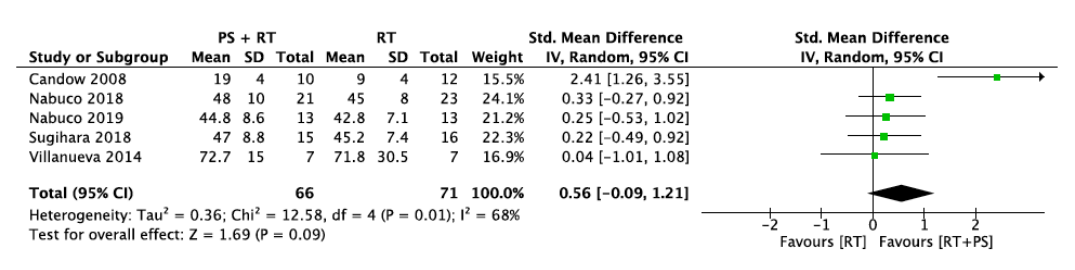
Figure 4. Impact of RT + PS on lower-limb strength.